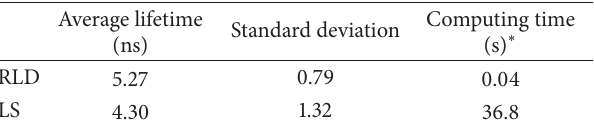
Figure 2: Nematode GFP-gated intensity images. Table 3: Comparison of exponential pattern model and polynomial